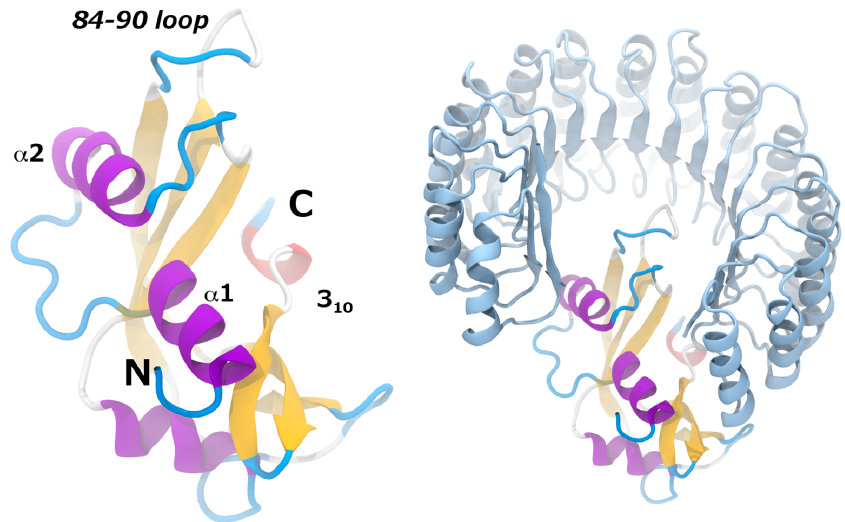
Figure 2. Left, Cartoon representation of the secondary structure of angiogenin. α -helices, β -strands, 3 10 helices and loops are shown respectively in purple, yellow, blue and red. The N and C labels indicate the position of angiogenin N- and C- terminals. Labeled helices α 1, α 2, 3 10 and the loop comprising residues 84–90 form important interactions with the RNH1 inhibitor. Right, cartoon representation of the angiogenin-RNH1 complex from X-ray experiments (PDB code 1A4Y).